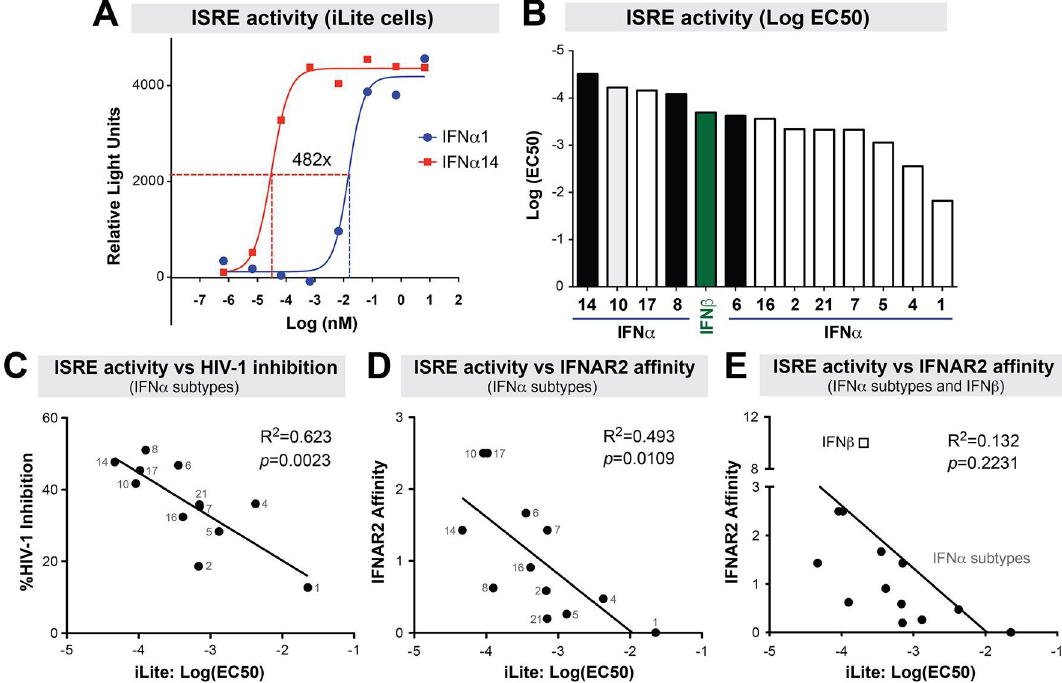
Fig 2. ISRE-activity of IFN-Is. IFN α subtypes and IFN β were titrated in iLite cells, a luciferase reporter cell line encoding the ISG15 - ISRE. (A) Determination of ISRE-activity. Serial dilutions of IFN-Is were incubated with iLite cells and luciferase readings were determined after 18 h. In this example, the titration curves for IFN α 1 and IFN α 14 are shown, showing a 482-fold difference in ISRE EC50 values. (B) ISRE-activity of IFN-Is. EC50 values are shown for all IFN-Is tested. IFN α subtypes that had potent activity against HIV-1 in a previous study are highlighted in black. IFN β is highlighted in green. Note that the EC50s are negative log values; thus the higher the bar, the less concentration is needed to achieve an EC50. (C) ISRE-activity versus HIV-1 inhibition. HIV-1 inhibition values were previously reported [12] showing % inhibition of HIV-1 p24+ cells relative to mock in LPMC cultures. ISRE-activity versus IFNAR2 binding affinity (D) without or (E) with IFN β . IFNAR2 binding affinity data were previously reported using surface plasmon resonance. For panels C to E, linear regression curves were plotted using Prism 5.0 and evaluated using Pearson statistics.